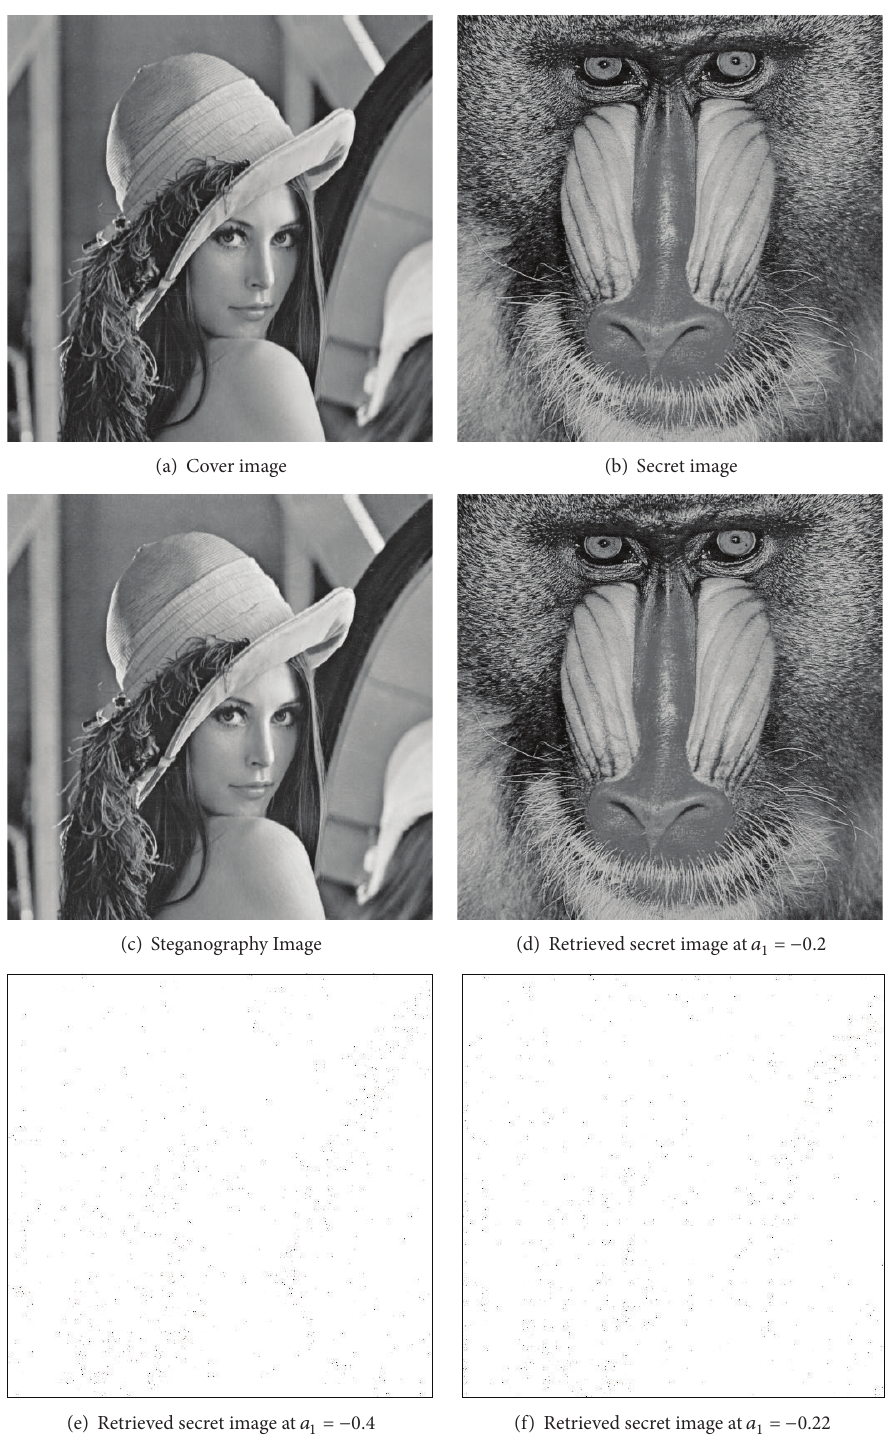
Figure 3: Steganography using